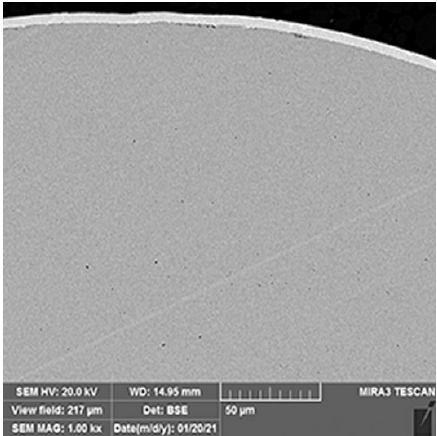
Figure 2. The principle of electrochemical formation of a composite coating on the surface of the wire.